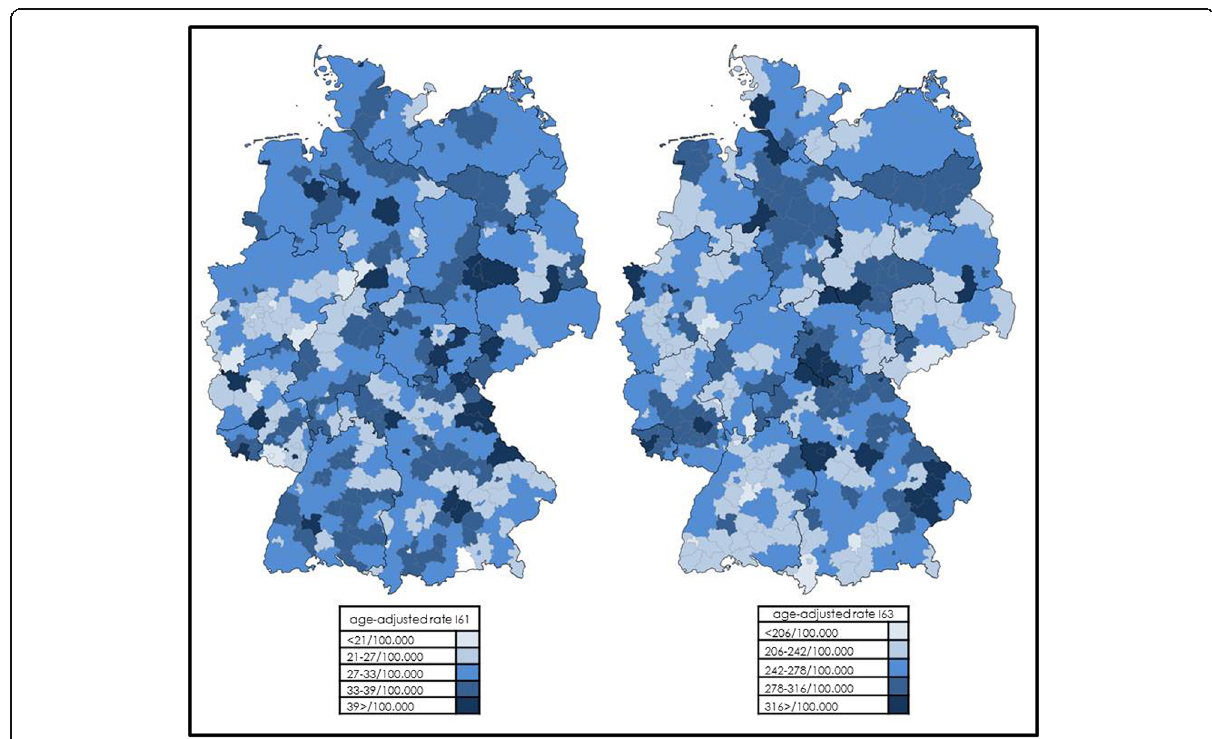
Fig. 2 Distribution of age-adjusted inpatient rates for ICH (I61) and AIS (I63) in Germany in 2017 according to 413* administrative districts and cities according to patients´ places of residence. I61: median 31/100.000, mean 31/100.000, sd 5.9, range 11 – 54/100.000. I63: median 259/100.000,